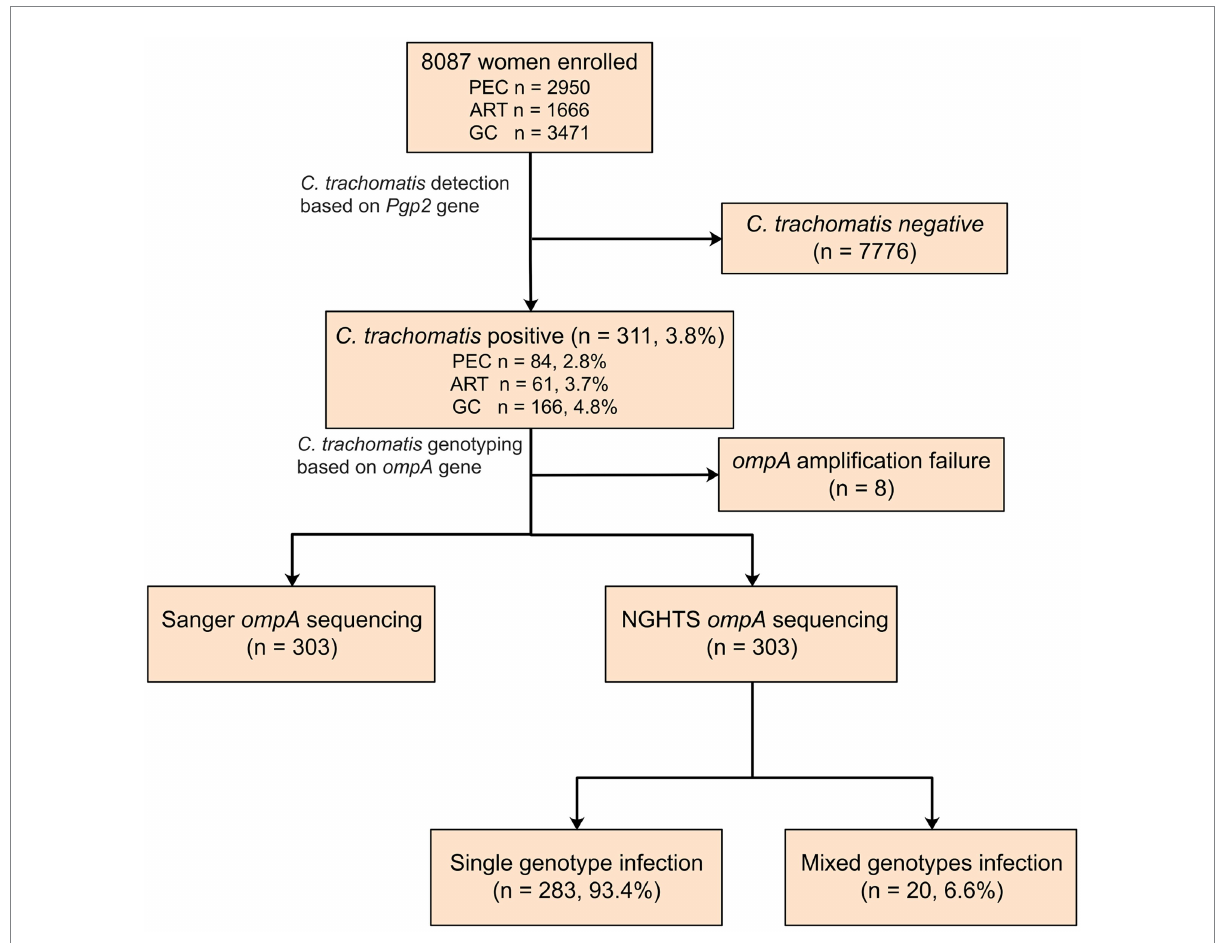
FIGURE 2 Flow chart for detection and genotyping of C. trachomatis in an observational study. The subjects were enrolled from physical examination center (PEC), assisted reproductive technology center (ART), or gynecology clinics (GC), respectively in a hospital in Chenzhou, China. They were first